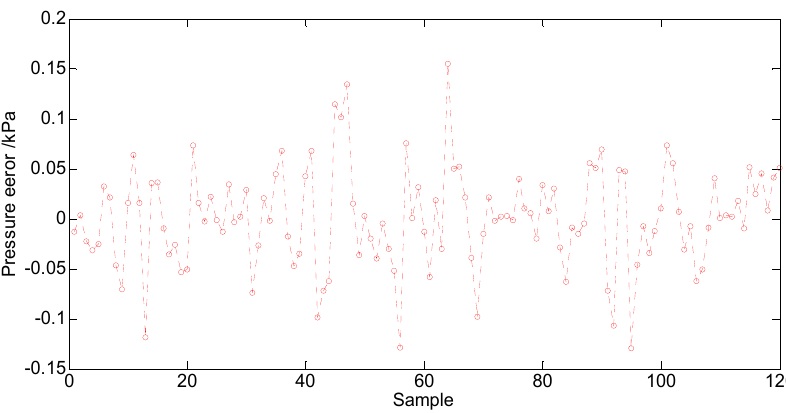
Figure 5. Output errors of upstream pressure.